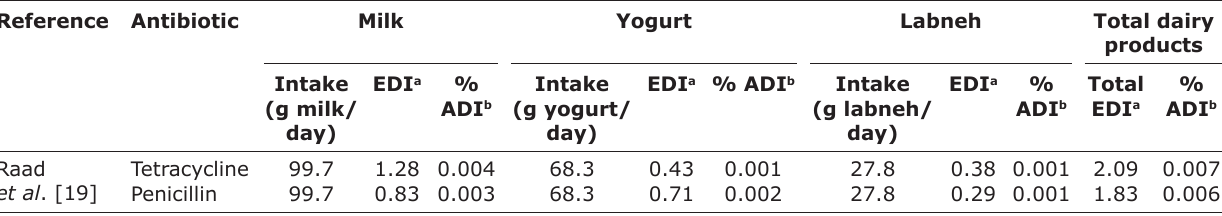
Table-3: Risk characterization of daily exposure to tetracycline and penicillin residues through intake of each of the dairy products individually as well as through intake of a combination of all dairy products. Reference